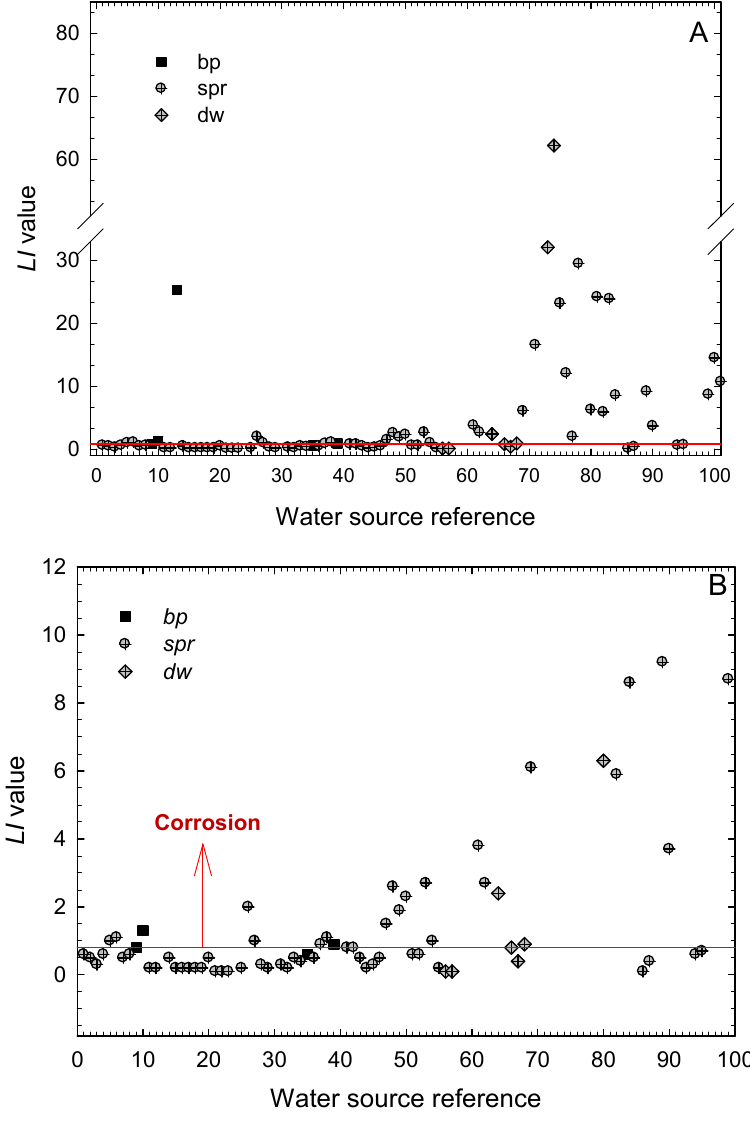
Figure 5. ( A ) Distribution of the water sources in the Azores archipelago according to their Larson–Skold Index (LI); and ( B ) Enlarged view of graph ( A